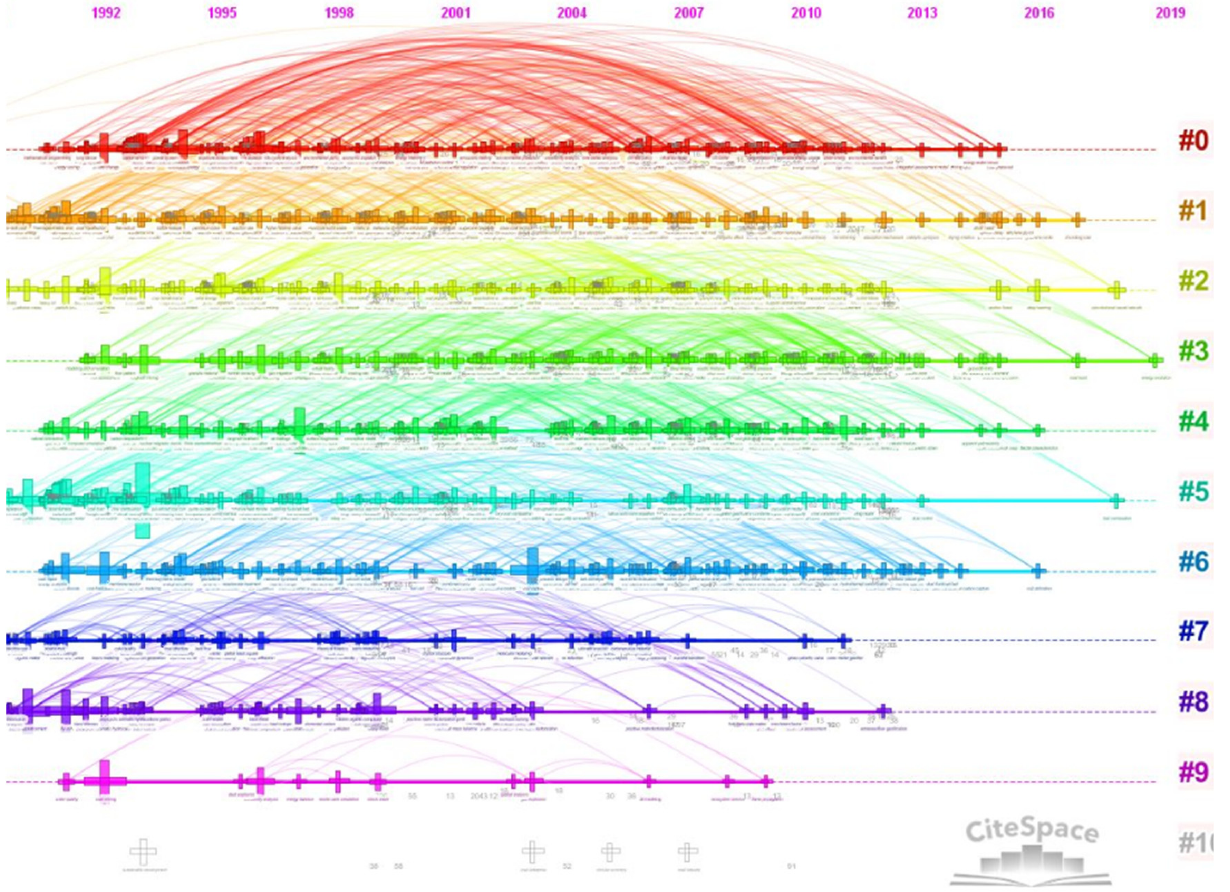
Figure 11. Results of clustering analysis over time.